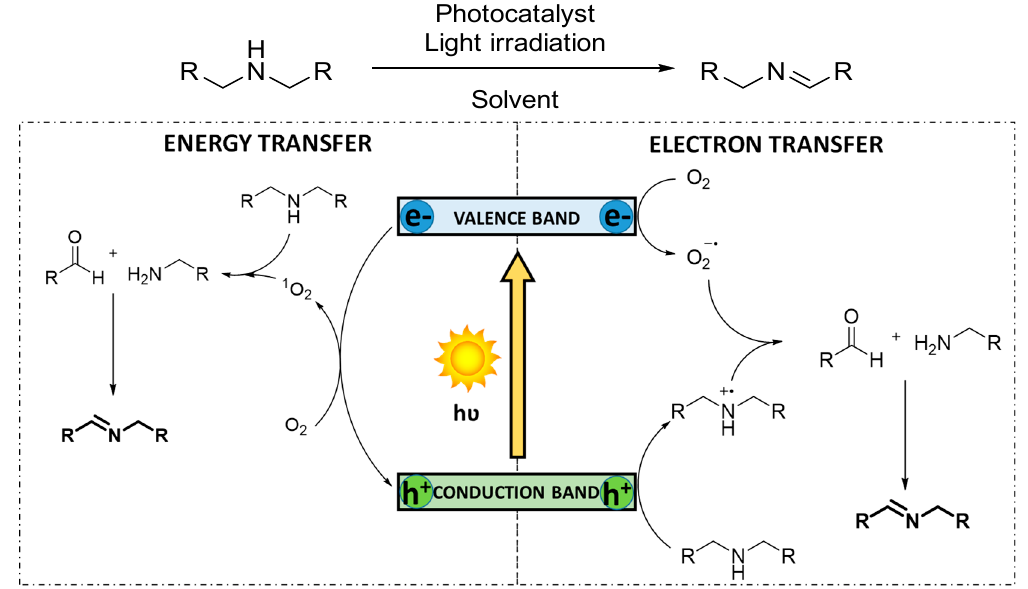
Table 5. Photooxidation reactions of secondary amines mediated by